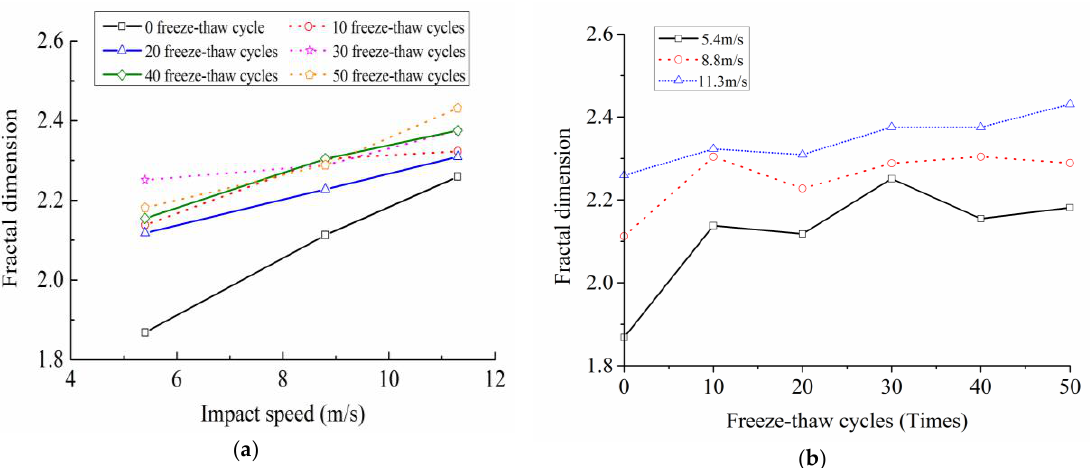
Figure 11. Variation rules of fractal dimension with loading speed and freeze-thaw cycles. ( a ) Variation rules of fractal dimension with loading speed; ( b ) Variation rules of fractal dimension with freeze-thaw cycles.